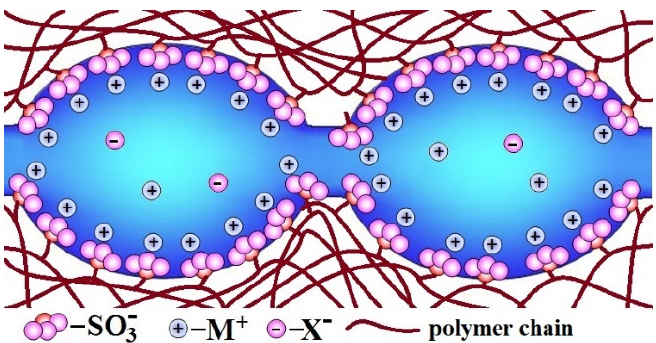
Figure 1. The scheme of pores and channels structure in the ion ‐ exchange membranes (redrawn from [62]).